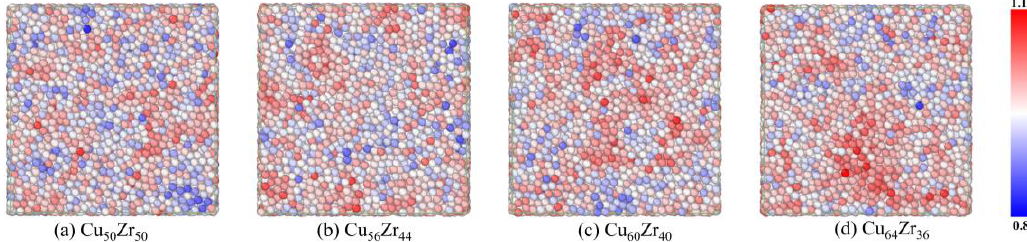
Figure 4. Atomic number density distribution of different component amorphous alloys. Here color red represents the high density region and color blue represents the low density region. ( a ) Cu 50 Zr 50 ,